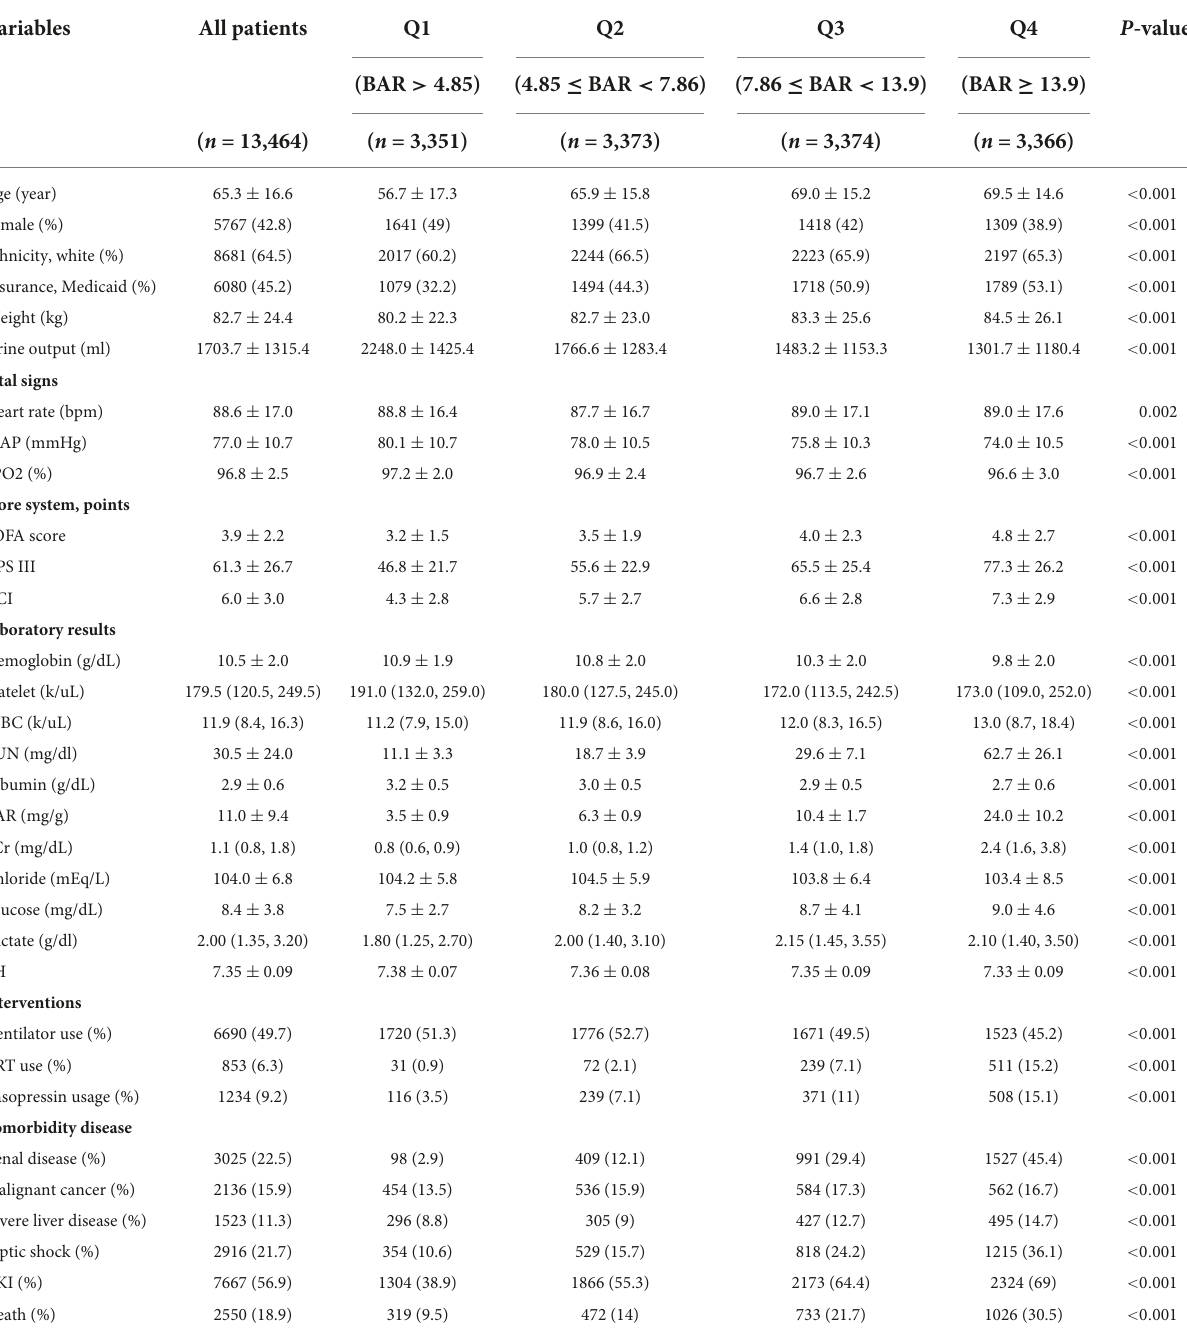
TABLE 1 Baseline characteristics of participants and outcome